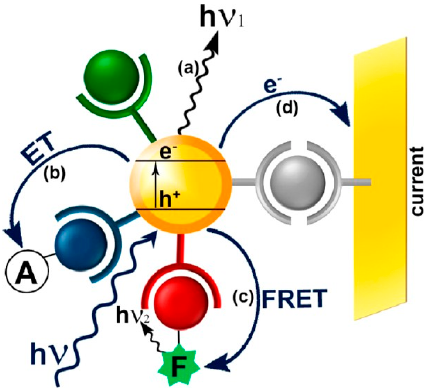
Figure 2. Schematic representation of different QD-based sensing configurations [26]. ( a ) luminescence, ( b ) electron transfer, ET, ( c ) Förster resonance energy transfer, FRET, or ( d ) photocurrent generation.